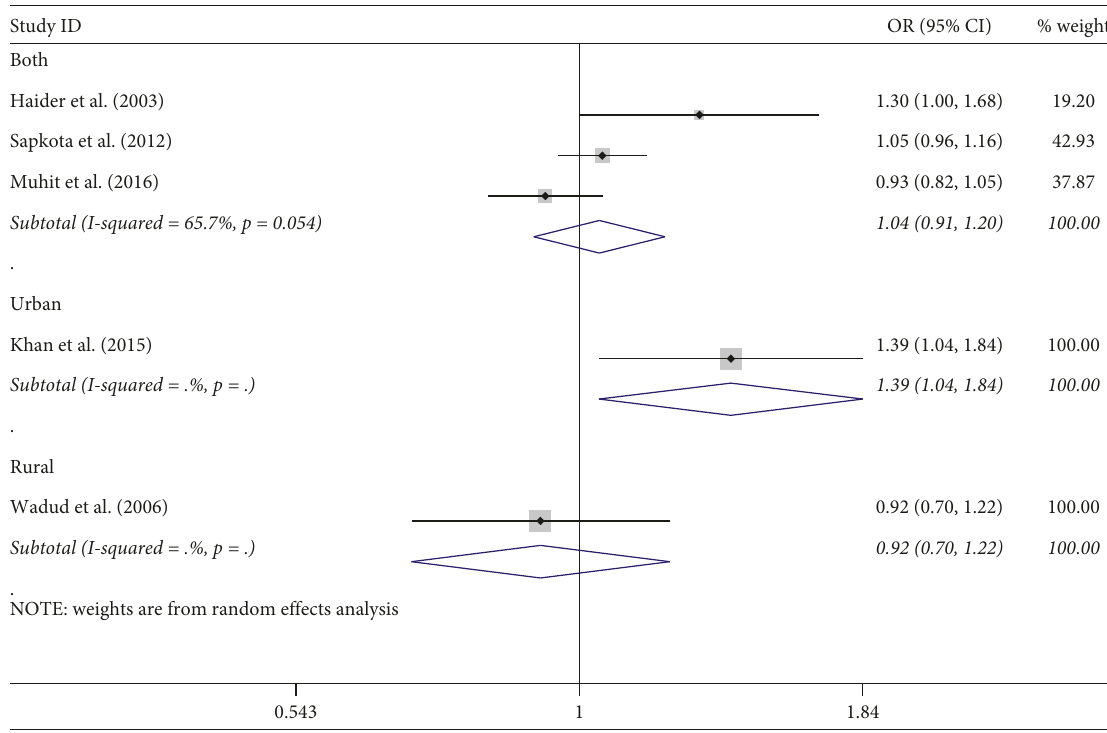
Figure 12: Subgroup analysis of CSC by location on an eye basis at visual < 6/18 level. CSC � cataract surgical coverage; OR � odds ratio; CI � confidence interval.